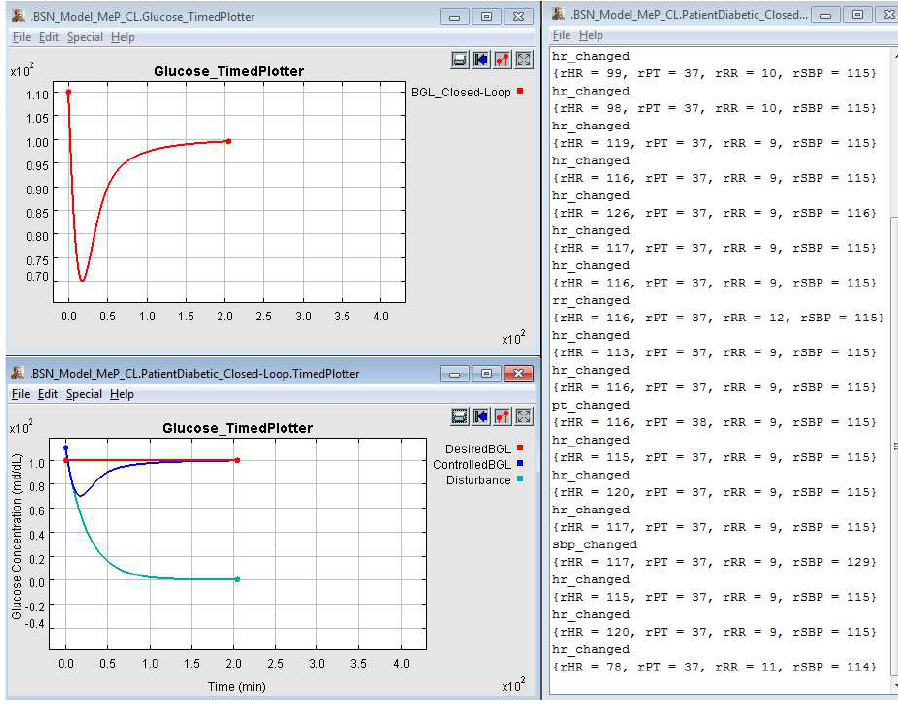
Figure 22. Simulation of an MCPS Model Using the Diabetic Patient